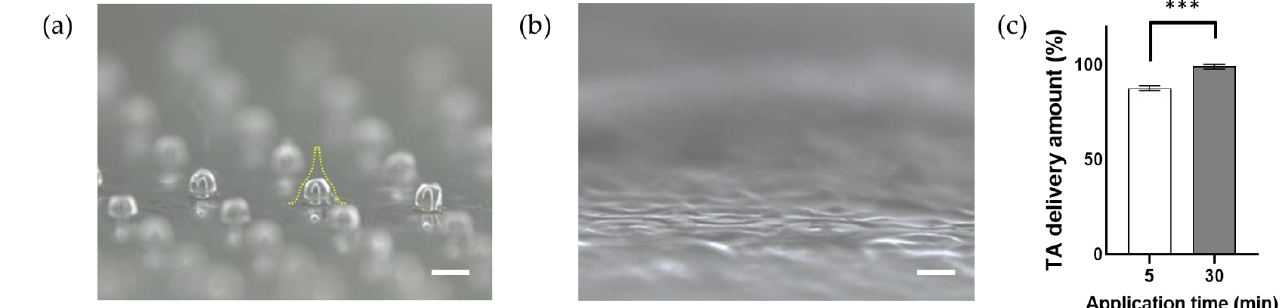
Figure 4. Transdermal delivery evaluation after TA-DMN patch application to porcine skin. ( a , b ) Images of remaining TA-DMNs after 5 and 30 min of application, respectively. Scale bar, 500 µm. ( c ) HPLC analysis of the amount of transdermal TA delivery after 5 and 30 min of application ( n = 3, each). Statistical significance was evaluated by Student’s t -test, and values of *** p < 0.001 were considered to be statistically significant.